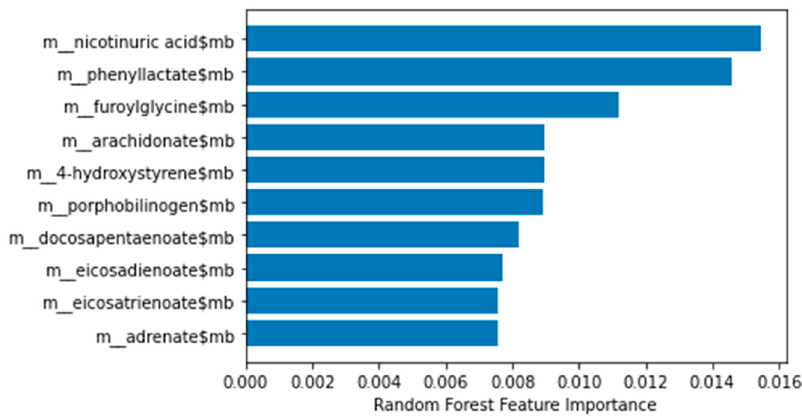
Figure 6. Feature importance (metabolomics data) with a RF. Only the first ten features are shown for illustrative purposes. Generated with a Python script.